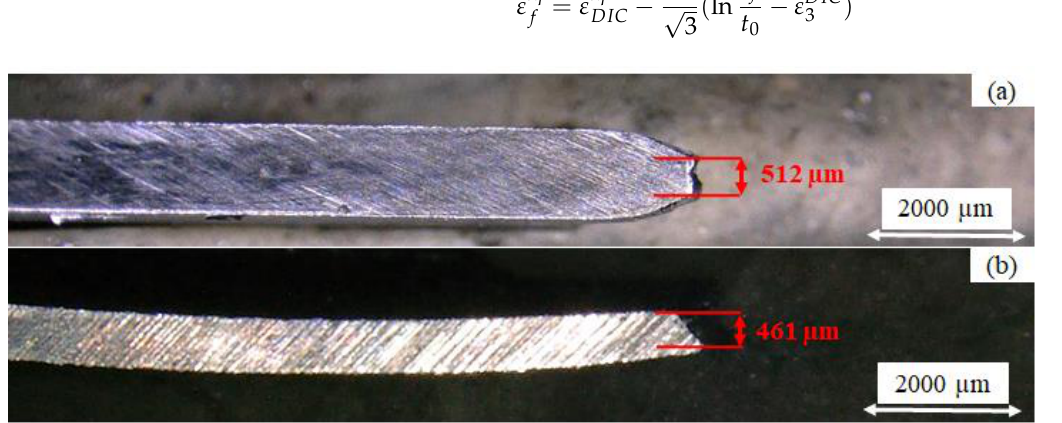
Figure 2. Thickness measurements for the ( a ) plane-strain notch tension (350 °C die-quenched) and ( b ) Nakazima (450 °C die-quenched) samples of Ductibor ® 1000-AS.